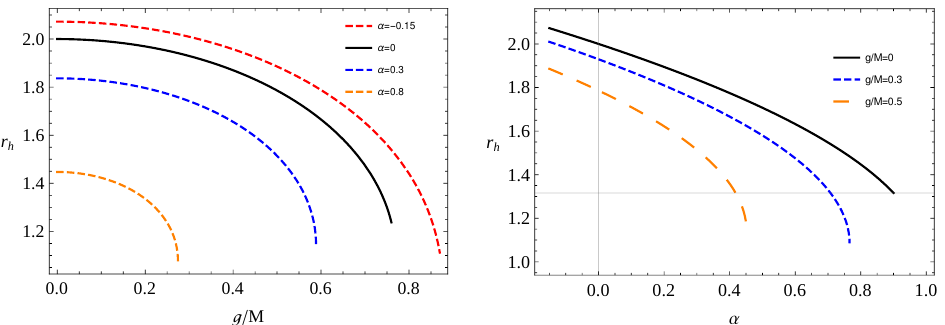
Figure 2. The dependence of outer event horizon on the parameters g ( left panel) and α ( right panel). Here, the radius of horizon of r h is normalized in M .